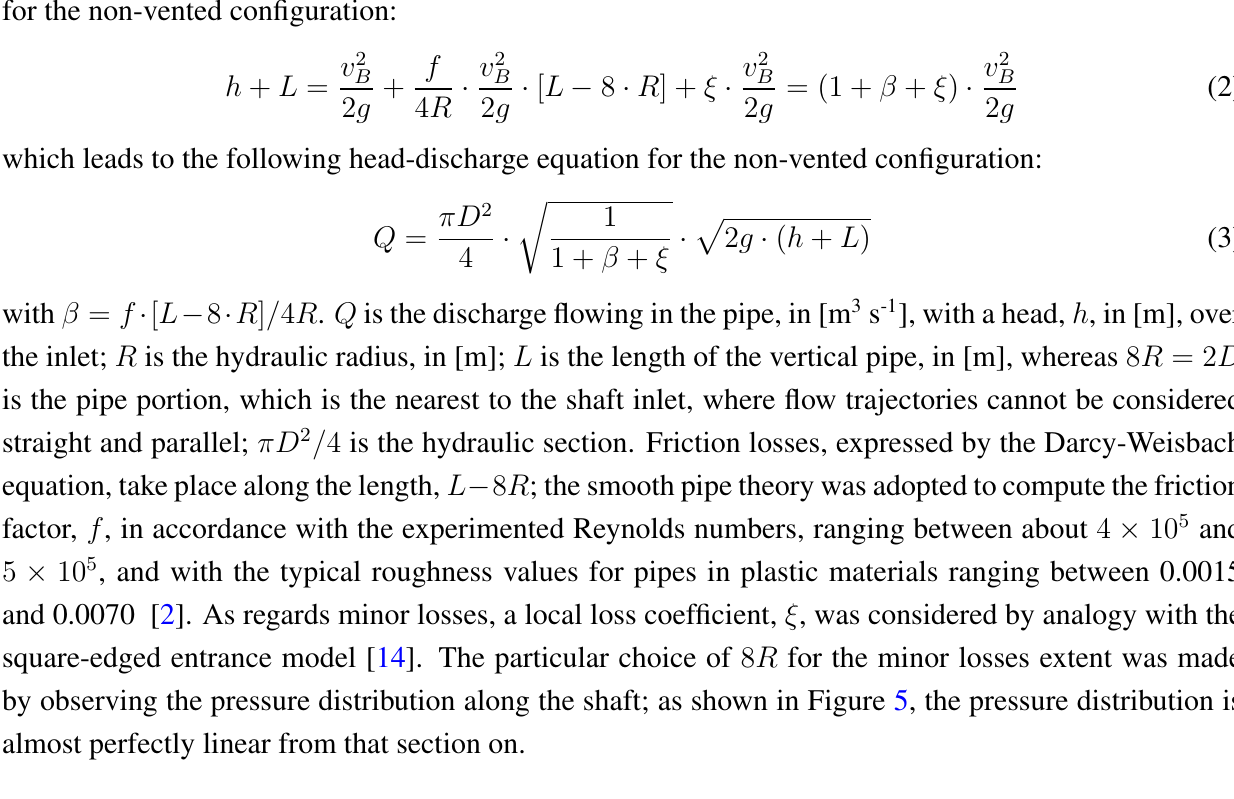
Figure 5. Pressure distribution along the drop shaft wall (experiment